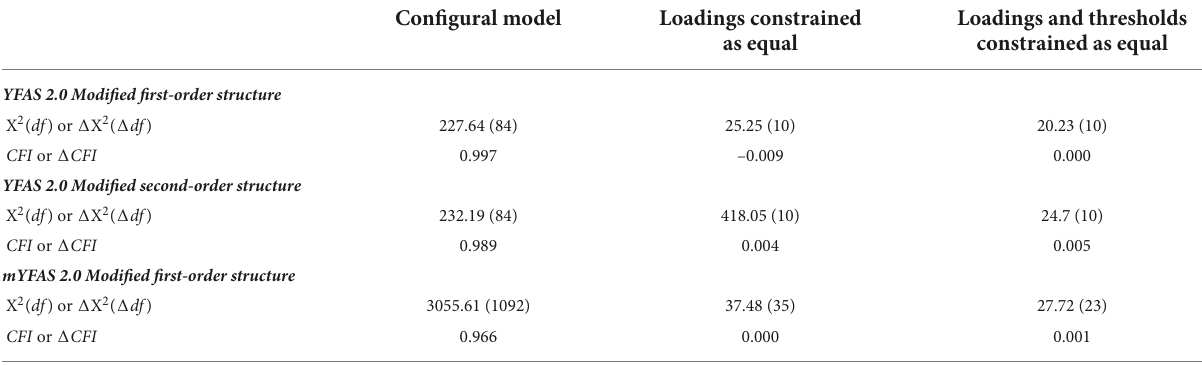
TABLE 5 Measurement invariance of the Yale Food Addiction Scale 2.0 (YFAS 2.0) and modified YFAS 2.0 (mYFAS 2.0) across sex. Configural model Loadings constrained Loadings and thresholds as equal constrained as